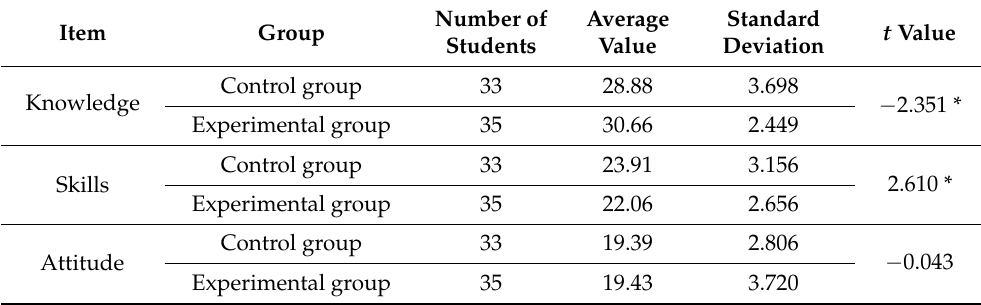
Table 4. Recapitulation sheet of students’ prior knowledge scores in knowledge, skills, and